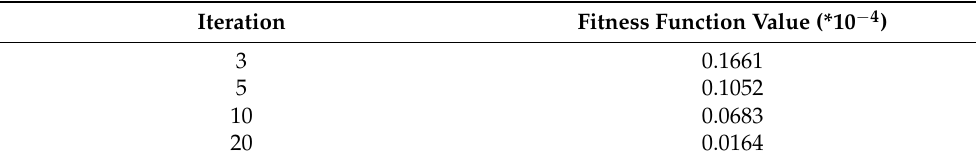
Figure 5. Speed transients’ changes during optimization.